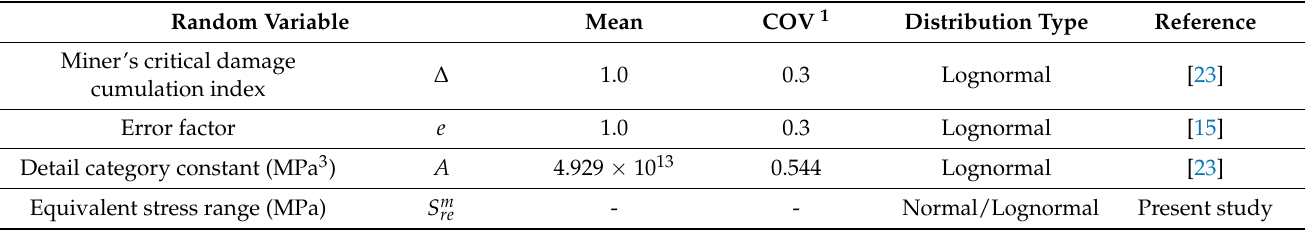
Table 3. The statistical parameters of the random